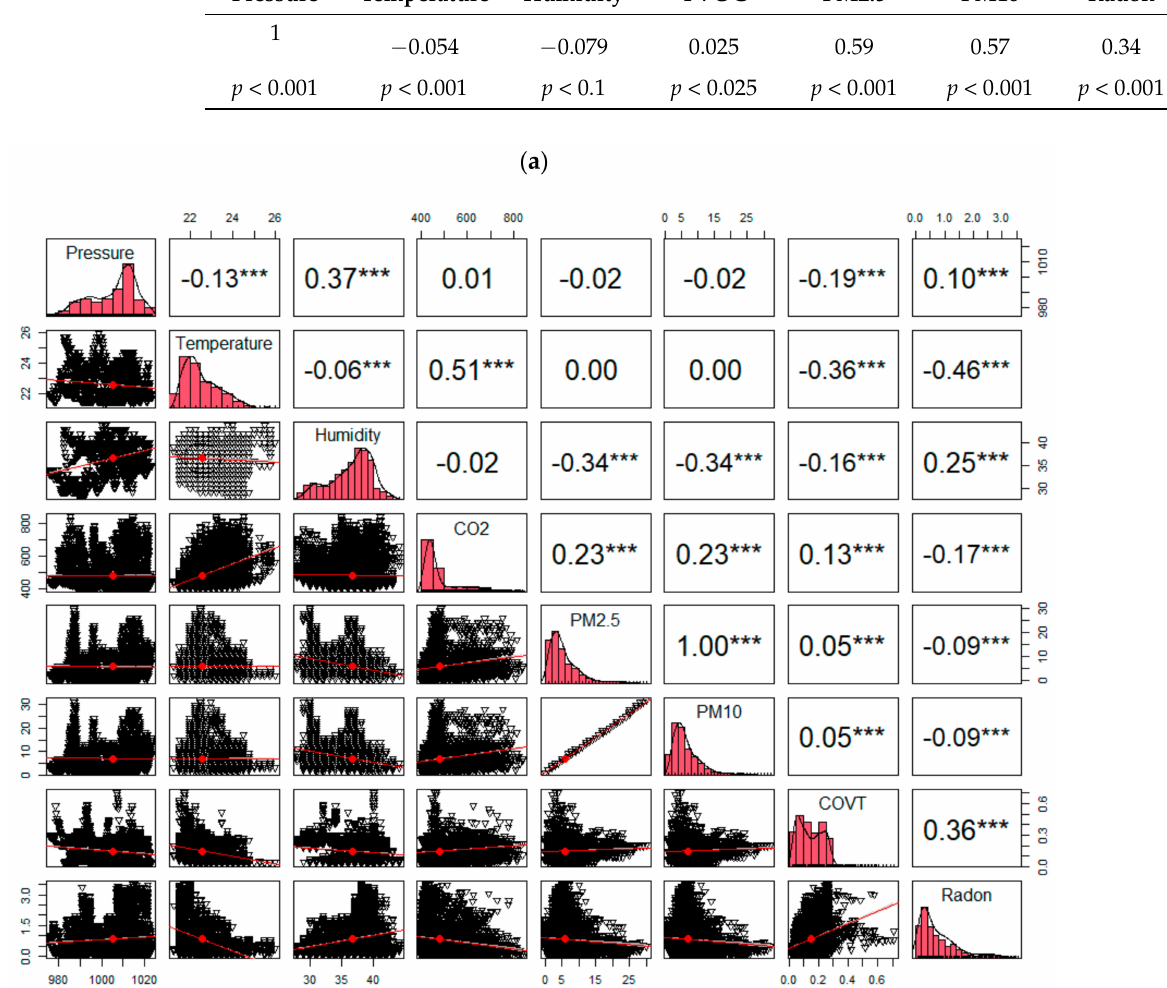
Table 8. Correlation frequency of 10-min for measurements in the corridor (B1) and the room (B2). Pressure